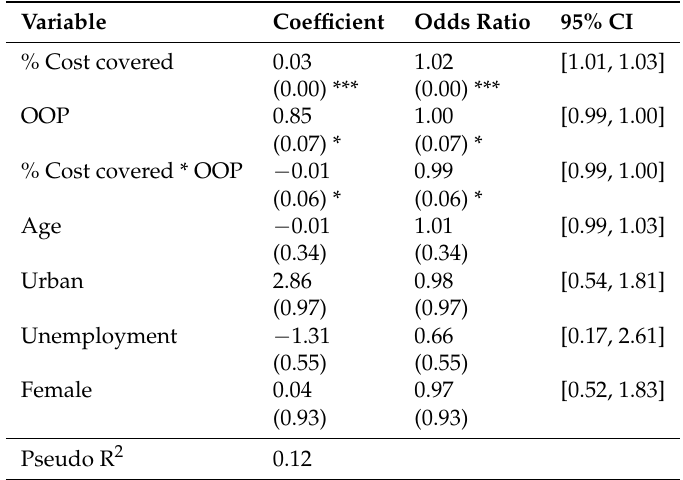
Table 6. The estimation of the 2009 health care reform’s effect on people’s decisions to visit tertiary hospitals. Variable Coefficient Odds Ratio 95% CI % Cost covered 0.03 1.02 [1.01, 1.03] (0.00) *** (0.00) *** OOP 0.85 1.00 [0.99, 1.00] (0.07) * (0.07) * % Cost covered * OOP − 0.01 0.99 [0.99, 1.00] (0.06) * Age